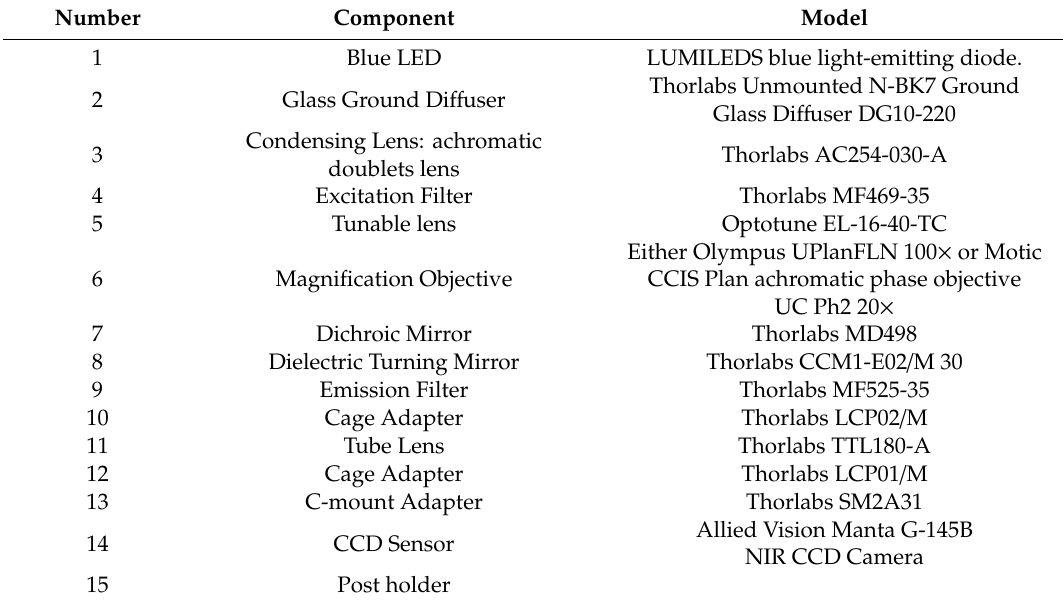
Table 1. Imaging components depicted in Figure